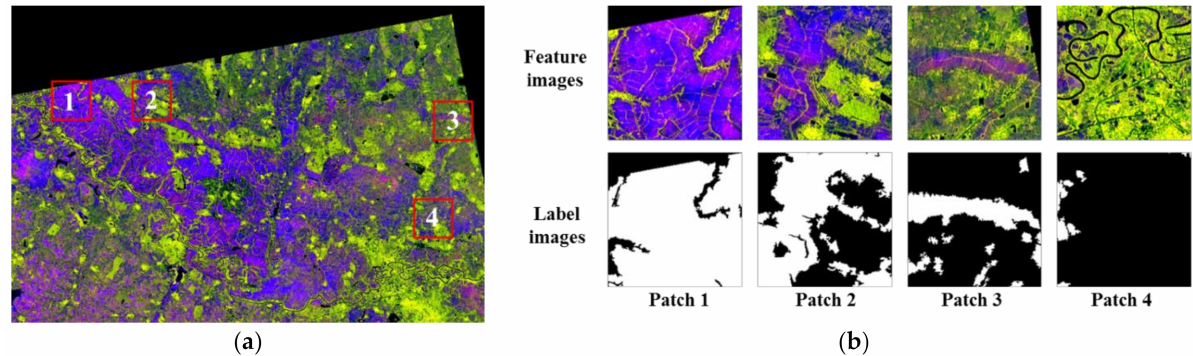
Figure 10. Examples of the training dataset, where the first row shows the input false-color images, and the second row shows the corresponding label images.